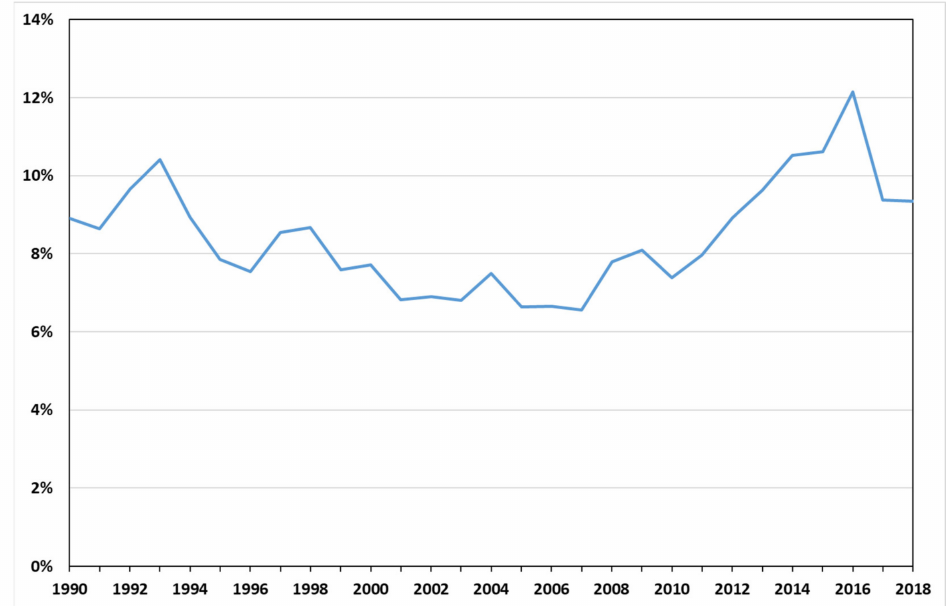
Figure 2. Emigration rate of the average non-German population (as %). (Sources: [56,57]; own computation and